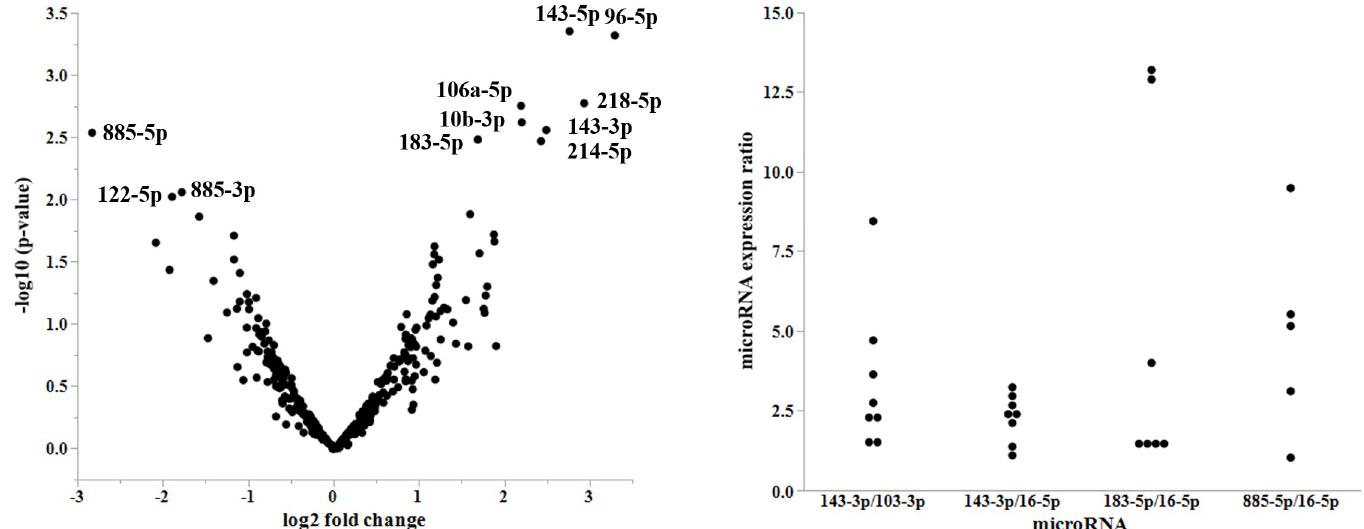
Fig 1. A. Volcano plot of microRNAs (miRNAs). This figure shows the expression levels of miRNAs in patients with familial adenomatous polyposis (FAP) compared to that in healthy donors. The differences are expressed as a log2 fold change on the X-axis and p-values on the Y-axis. B. Variation of microRNAs (miRNAs) expression levels. Expression ratios of the indicated miRNAs at different time points are